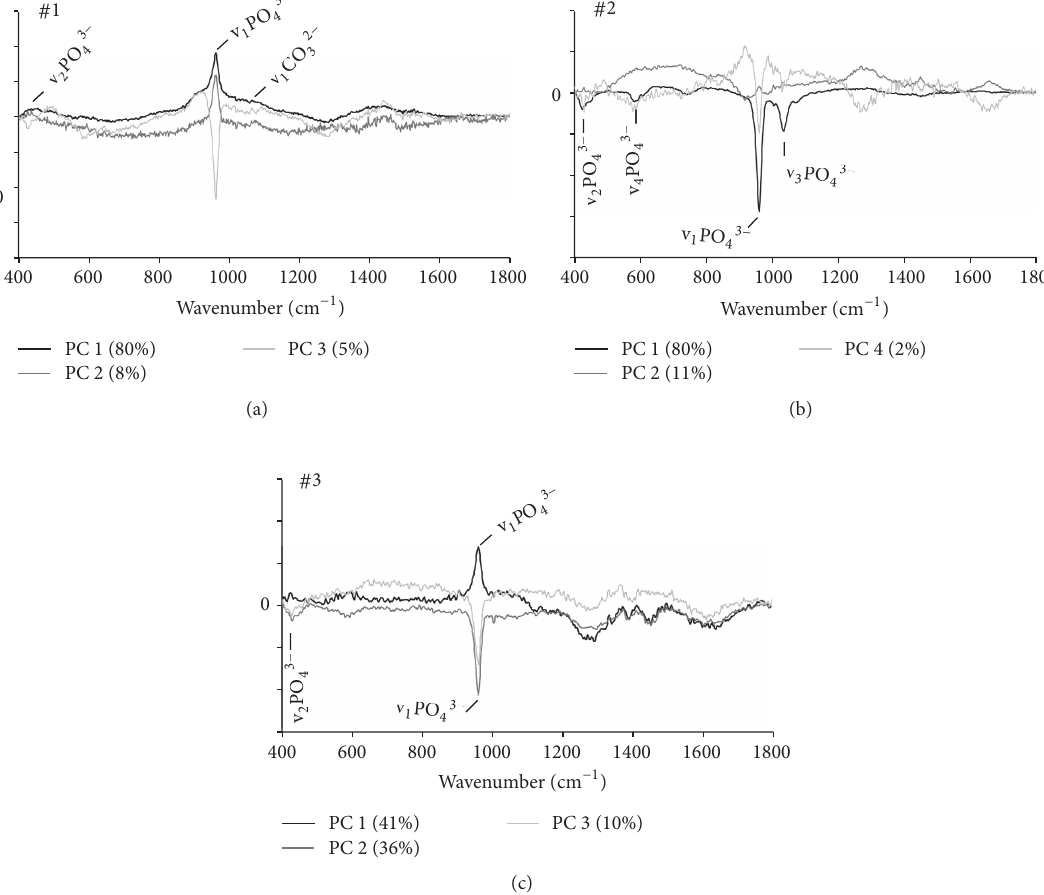
Figure 4: Loadings of PCA describe the mineralization for each patient. (a) PC 1, PC 2, and PC 3 loadings demonstrate strong influences of hydroxyapatite peaks (v 2 PO 43− , v 1 PO 43− ) at 961 and 430 cm −1 in the PCA of Raman spectra from patient #1 (Figure 3(a)). (b) PC 1, PC 2, and PC 4 loadings referring to the PCA of patient #2 (Figure 3(b)) exhibit the four major hydroxyapatite vibrations. (c) Loadings of PC 1, PC 2, and PC 3 validate that the Raman spectra of patient #3 exhibit signals from